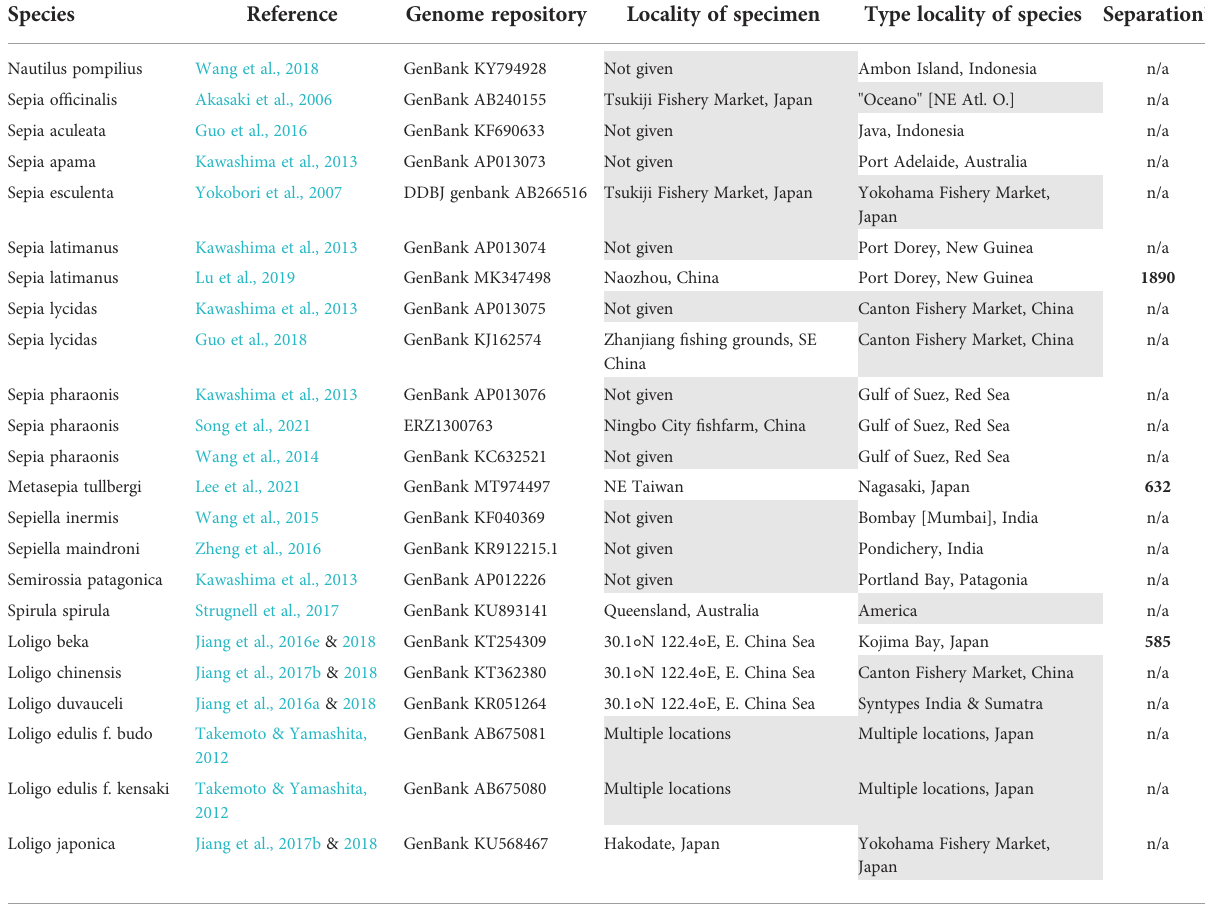
TABLE 1 Mitochondrial genome sequences for cephalopods in recent